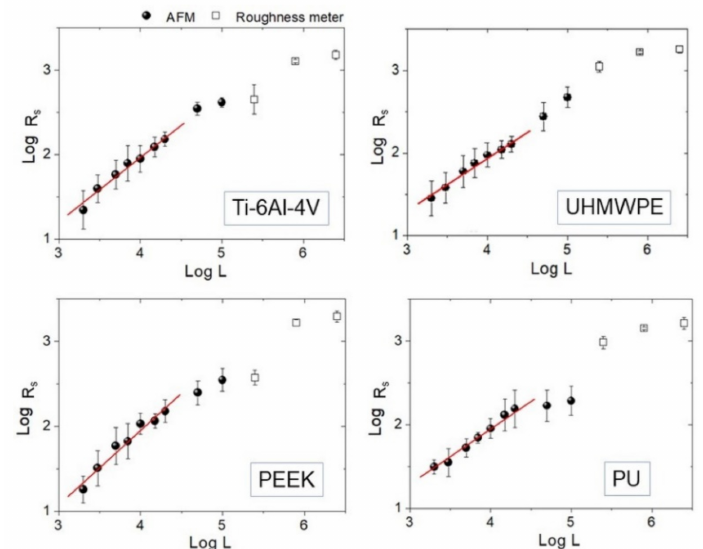
Figure 4. Log-Log plots of R s vs. L curve for each sample. Experimental points measured by AFM (black round dots) and roughness meter (square dots) are reported together. Linear fittings on AFM data below L = 20 µ m are also